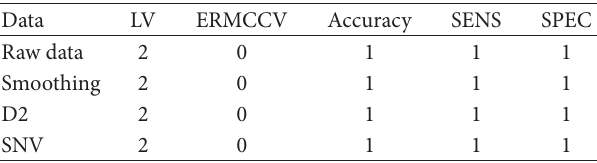
Table 2: Discrimination of regular and Hg-contaminated MFLW by PLSDA of NIRS